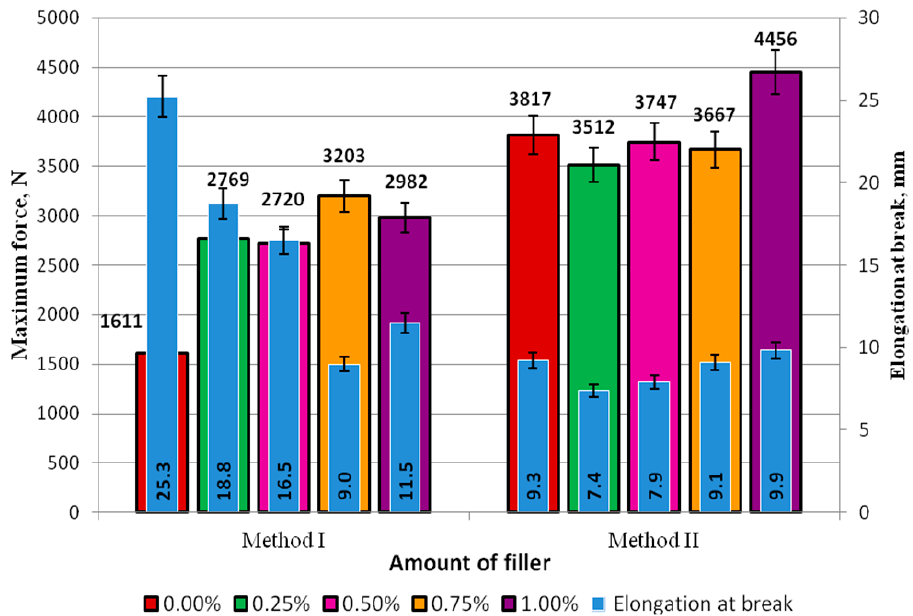
Figure 7. Comparison of the maximum force and elongation at break in the adhesive specimens prepared with Methods I and II.